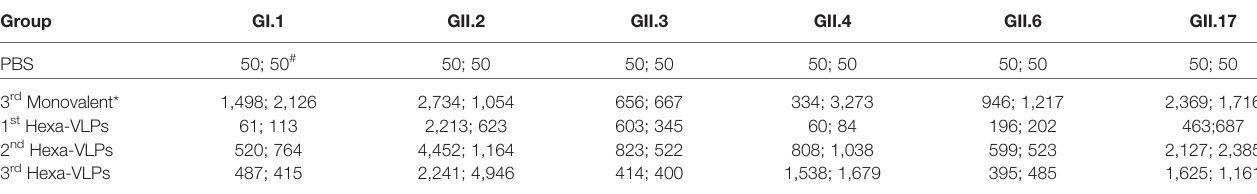
TABLE 2 | 8 w and 12 w GMBT50 enumeration of different regimens. Group